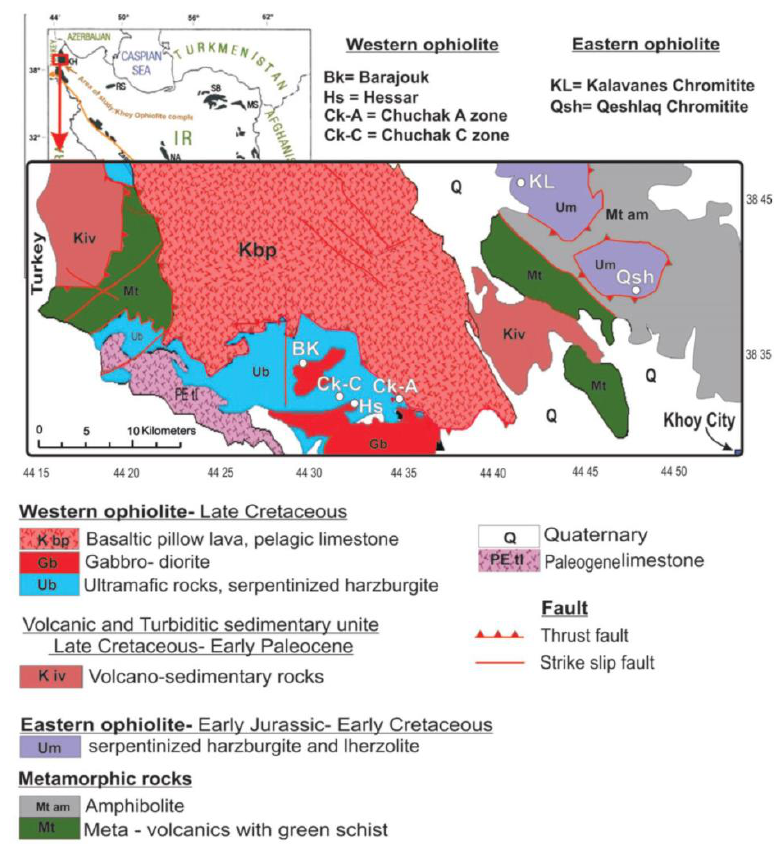
Figure 1. Geological map of the study area (modified after Khoy 1:250,000 geological map) and sample locations associated with a sketched map of Iran showing locations of some of the most important ophiolites in Iran [6,19]. KH, Khoy; MS, Mashhad; RS, Rasht; SB,